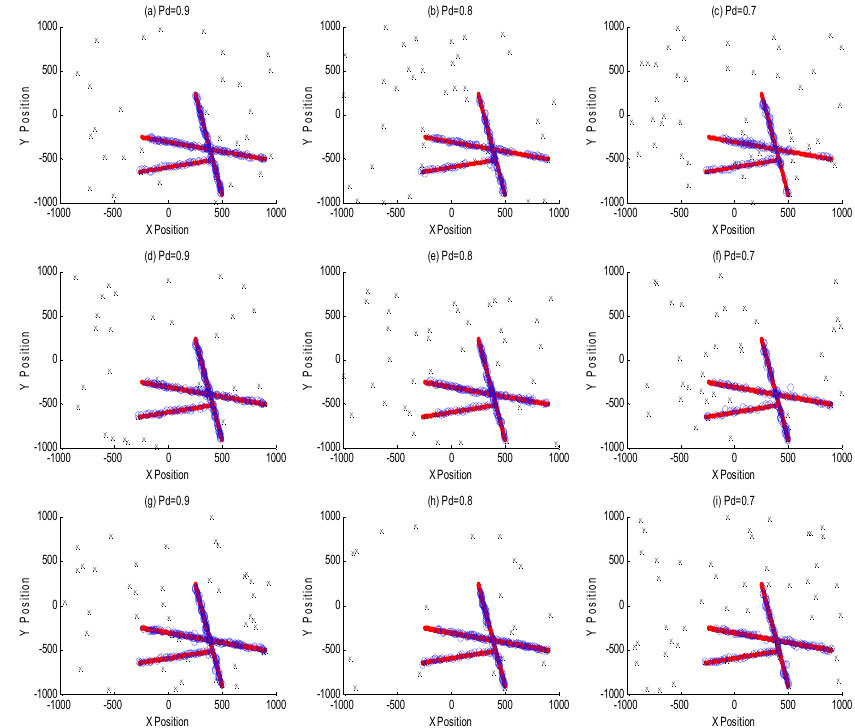
Figure 10. Feedback/ no feedback tracking results. ( a – c ) are no feedback results; ( d – f ) are local sensors tracking results after feeding back two sensors fusion results; ( g – i ) are local sensors tracking results after feeding back three sensors fusion results.